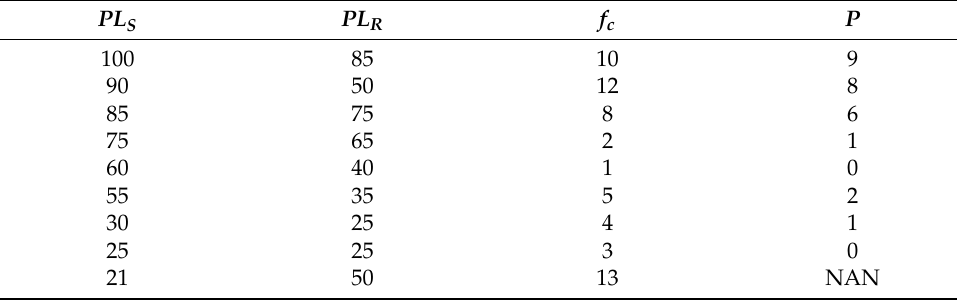
Table 2. Timer period for different PL and f c.